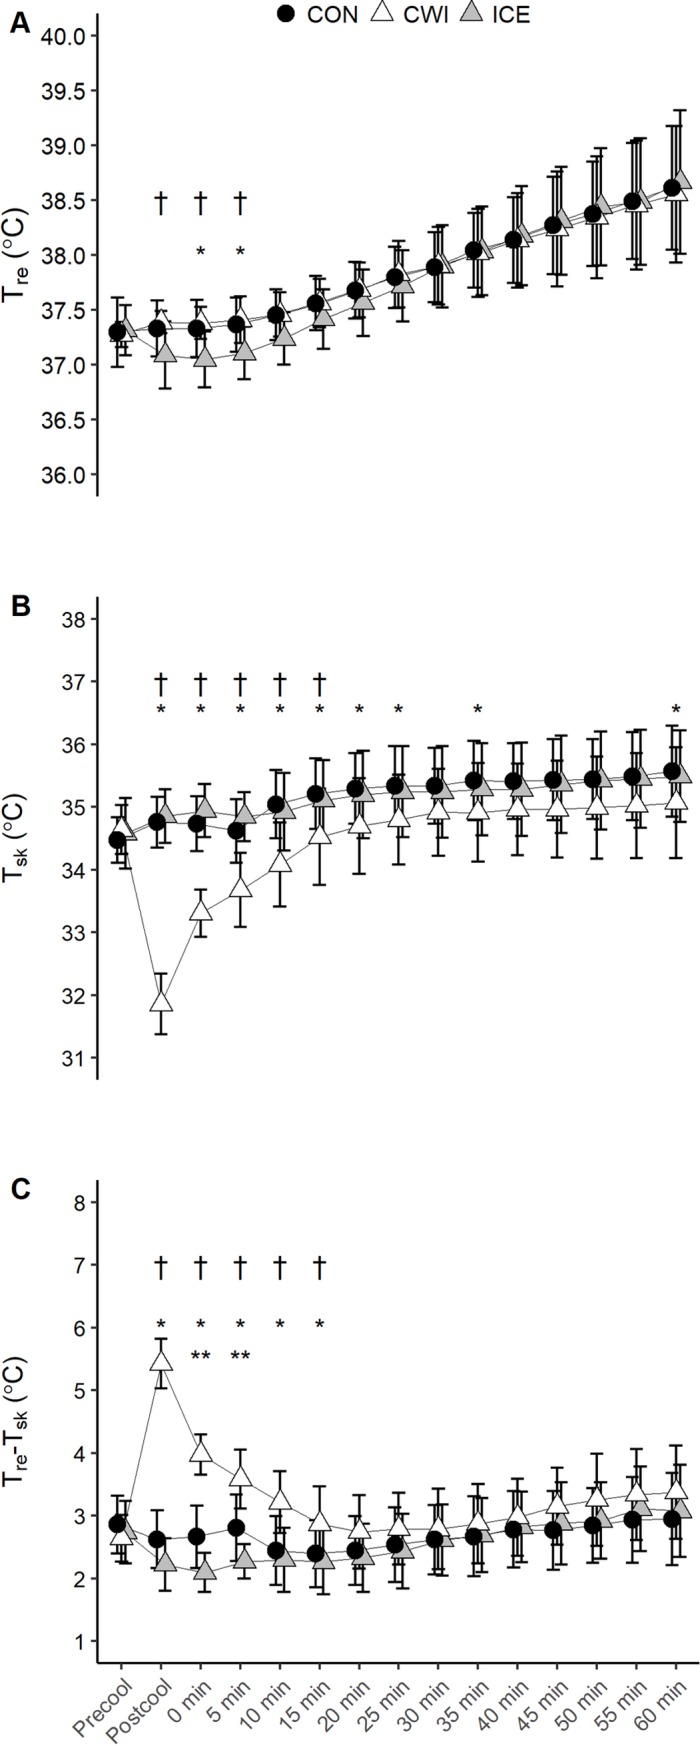
Tre (A), Tsk (B), and
Tre-Tsk gradient (C) during 60 min of
cycling at fixed intensity (study 1). CON, control; CWI,
cold water immersion; ICE, ice slushy ingestion; * p<0.05 CWI
versus CON; ** p<0.05 ICE versus CON; † p<0.05 CWI versus ICE.
Data are mean ± SD for n = 11 for Tsk.
Due to missing data at certain time points during the exercise, data
for Tre and Tre-Tsk gradient are
n = 10 during the first 10 min of exercise for
all conditions and n = 8 or 9 thereafter (see S1 and S2 Tables for clarification).